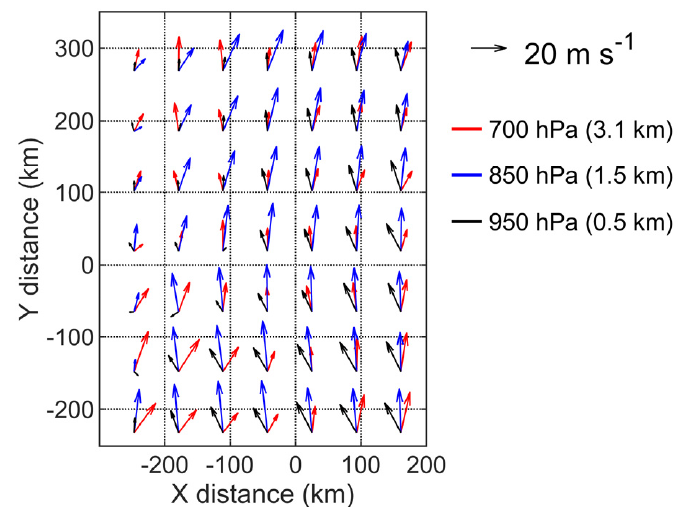
Figure 4. Wind field from ERA5 reanalysis data at 09:00 UTC.